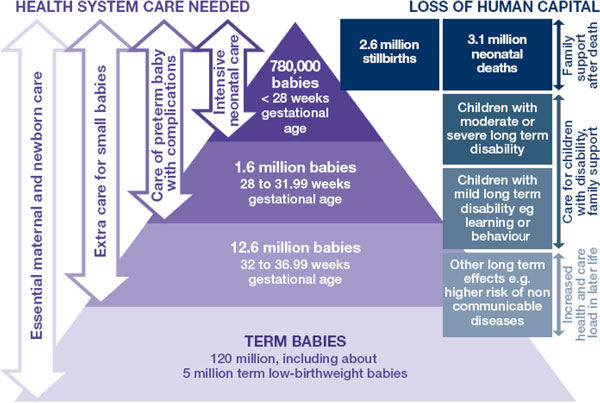
135 million newborns and 15 million premature babies-health system needs and human capital outcomes around the year 2010. Source: Born Too Soon report, chapter 5 [113]. Analysis using data from Blencowe et al., 2012 [1]; Cousens et al., 2011 [114]; Liu et al., 2012 [8].